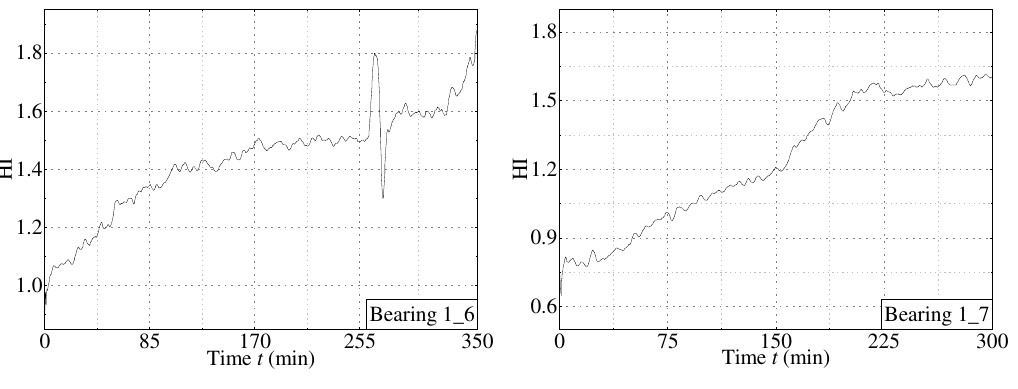
Figure 18. HI curves of the testing bearings.